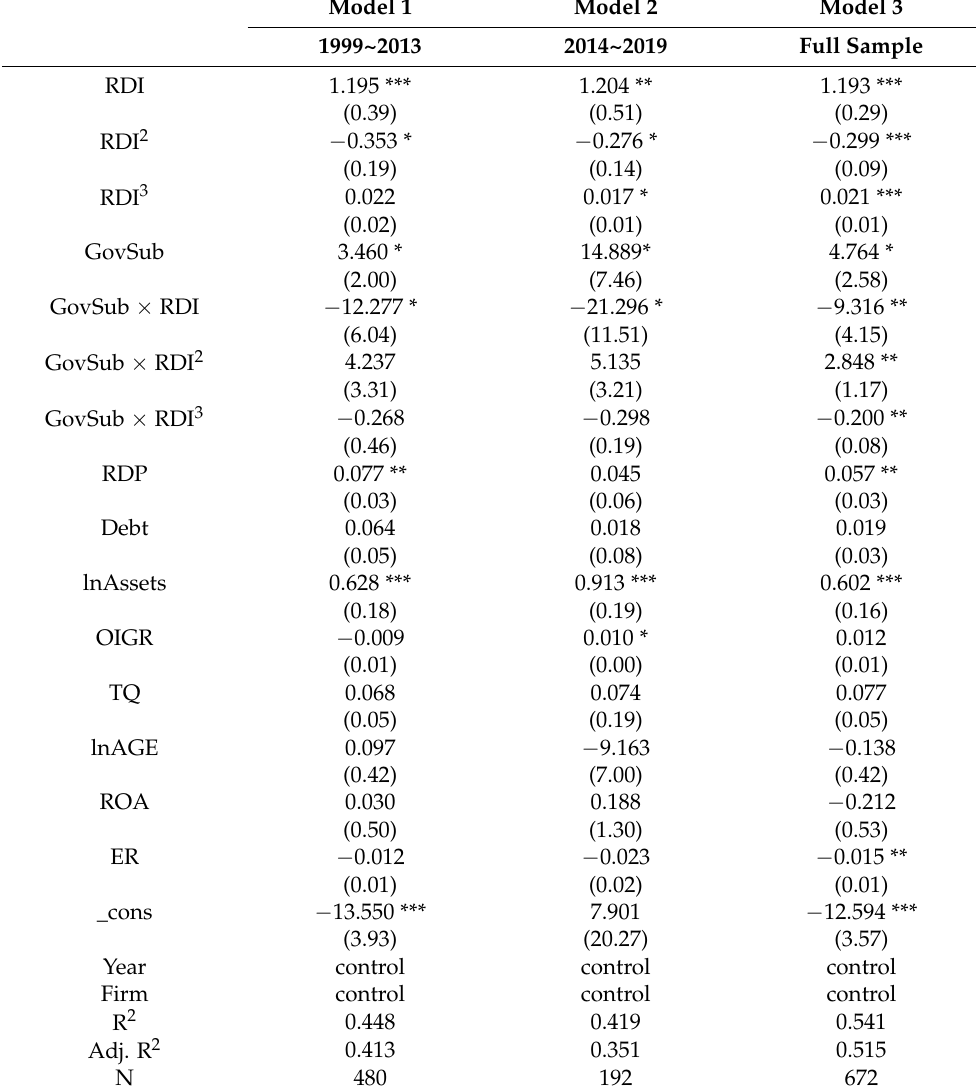
Table 6. Staged regression